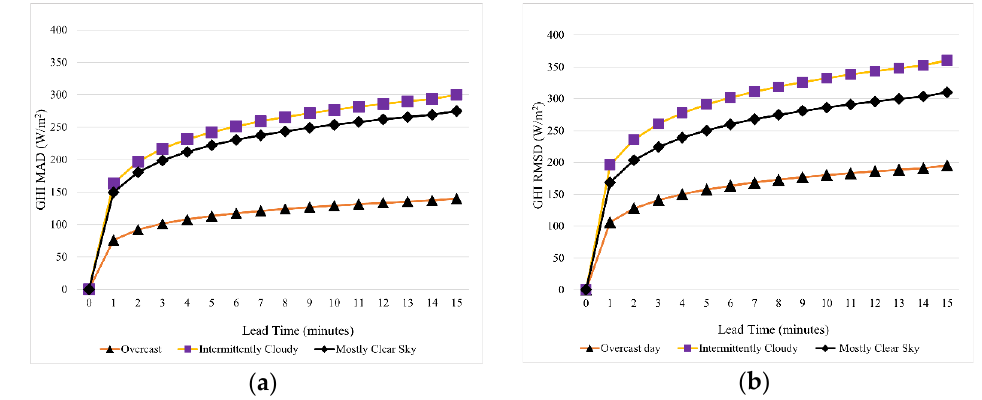
Figure 13. ( a ) GHI MADs for the three classes. ( b ) GHI RMSDs for the three classes.